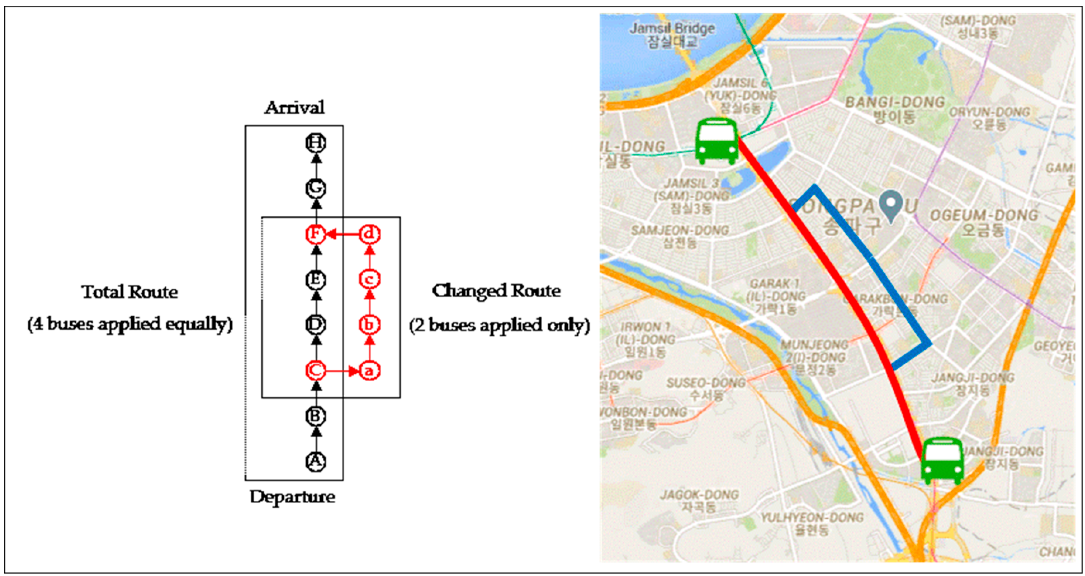
Figure 4. Bus map for existing and changed routes.